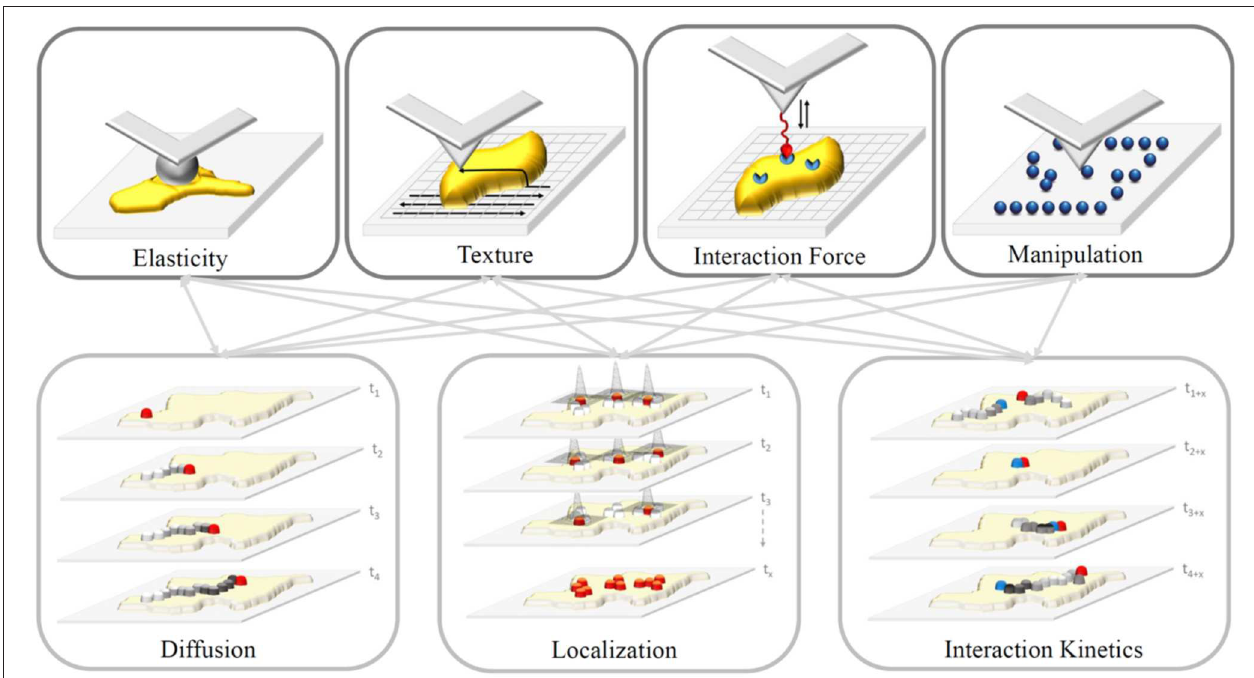
FIGURE 4 | Sketch of properties gained from AFM (upper row) and FM-based (lower row) techniques. Gray arrows depict possible combinations of properties. In general, we can differentiate acquired information premised on AFM, whether they are generated via force spectroscopy (measurement of interaction forces via functionalized tips or elasticity via ball-bearing tips) or by spatial scanning (sample texture or feature manipulation depending on the applied force) of the sample (yellow). In contrast, FM-based techniques study movement (e.g., diffusion) and interaction kinetics of molecules, and localize these particles down to an accuracy of a few nanometers depending on the number of detected